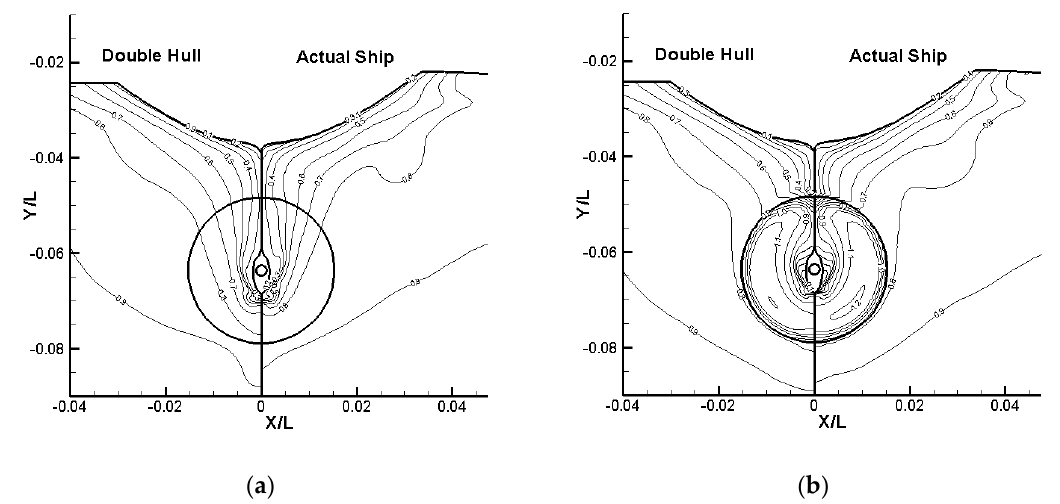
Figure 23. Axial velocity isowake curves on the propeller plane; on the left is the double body case and on the right the ship in calm water, for ( a ) the towed ship and ( b ) the self-propelled ship.